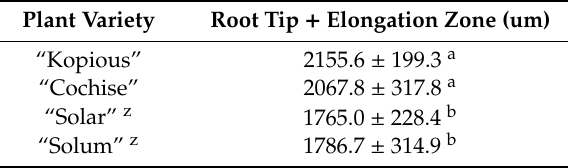
Table 4. Decreased root elongation zone in drought tolerant z barley varieties.